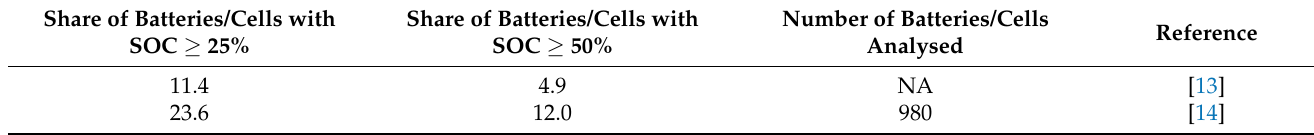
Table 2. Distribution of state of charge (SOC) of end-of-life lithium-ion batteries. Share of Batteries/Cells with SOC ≥